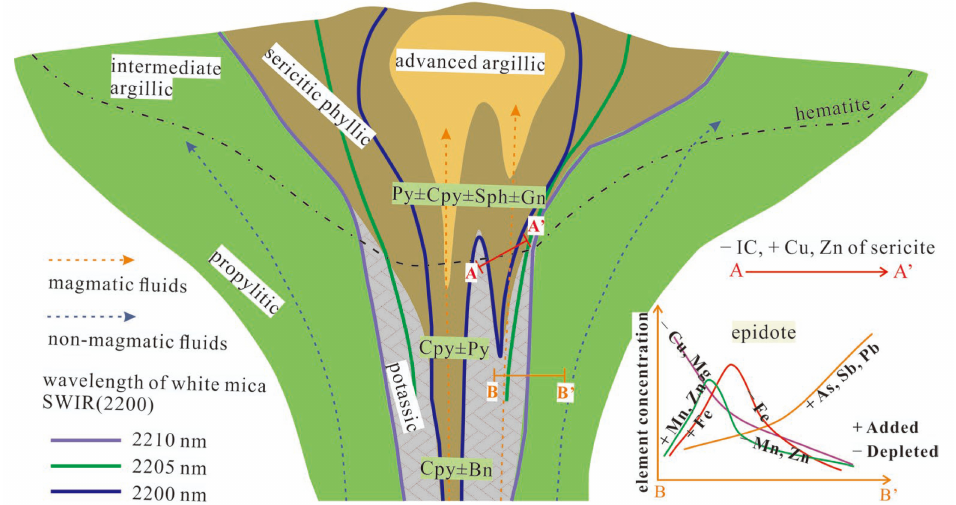
Figure 3. Vertical cross section of a typical porphyry Cu deposit showing the distribution of hy- drothermal alteration, sulfide minerals, and generalized contours of the 2200 nm peak (modified from [26]). Also shown are generalized spatial variations in mineral chemistry of sericite and